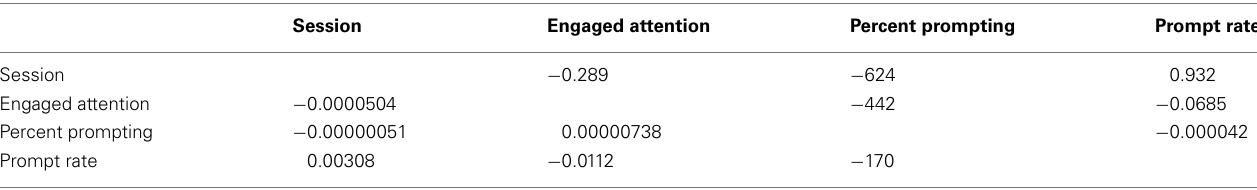
Table 7 | Relationships amongst independent variables.